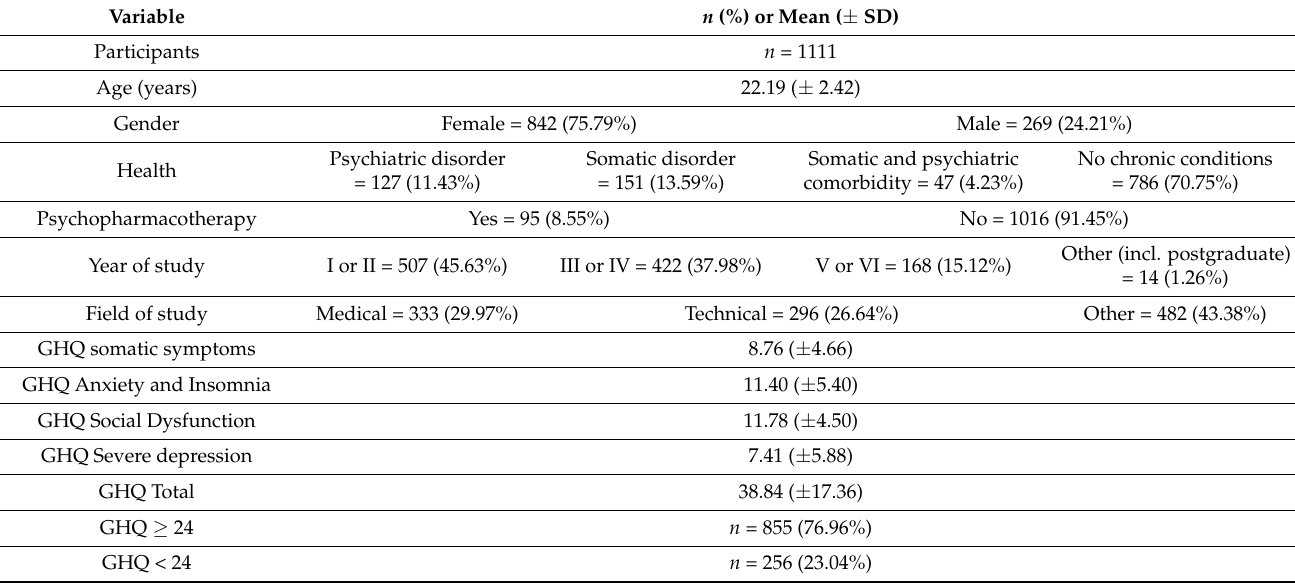
Table 1. Basic demographic and health data and Global Health Questionnaire (GHQ) scores. SD—standard